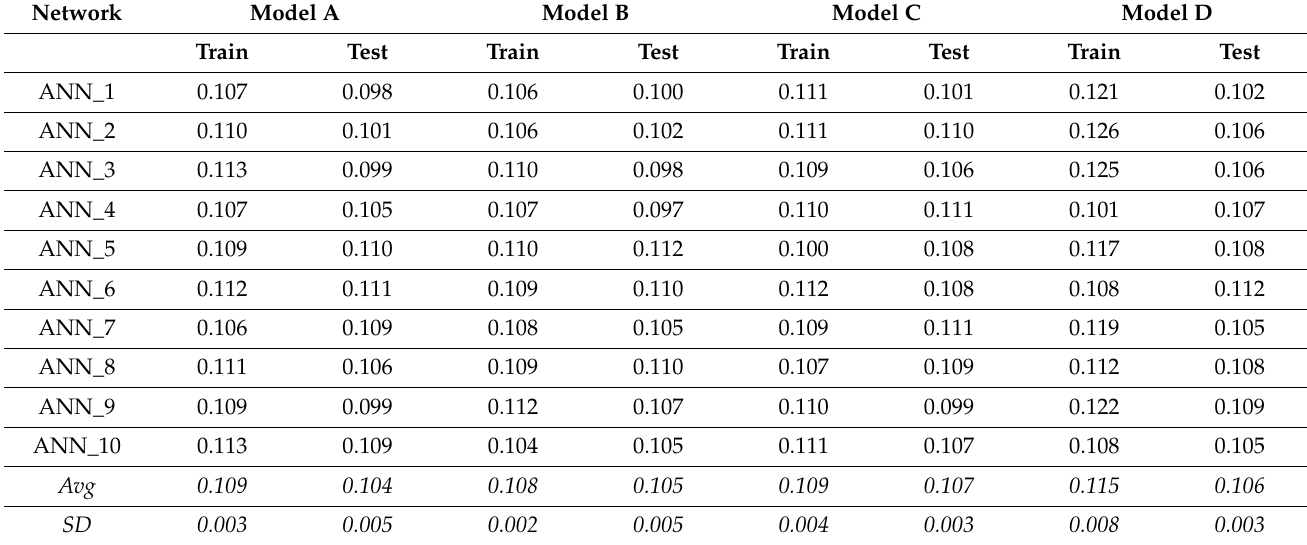
Table 6. RMSE for the